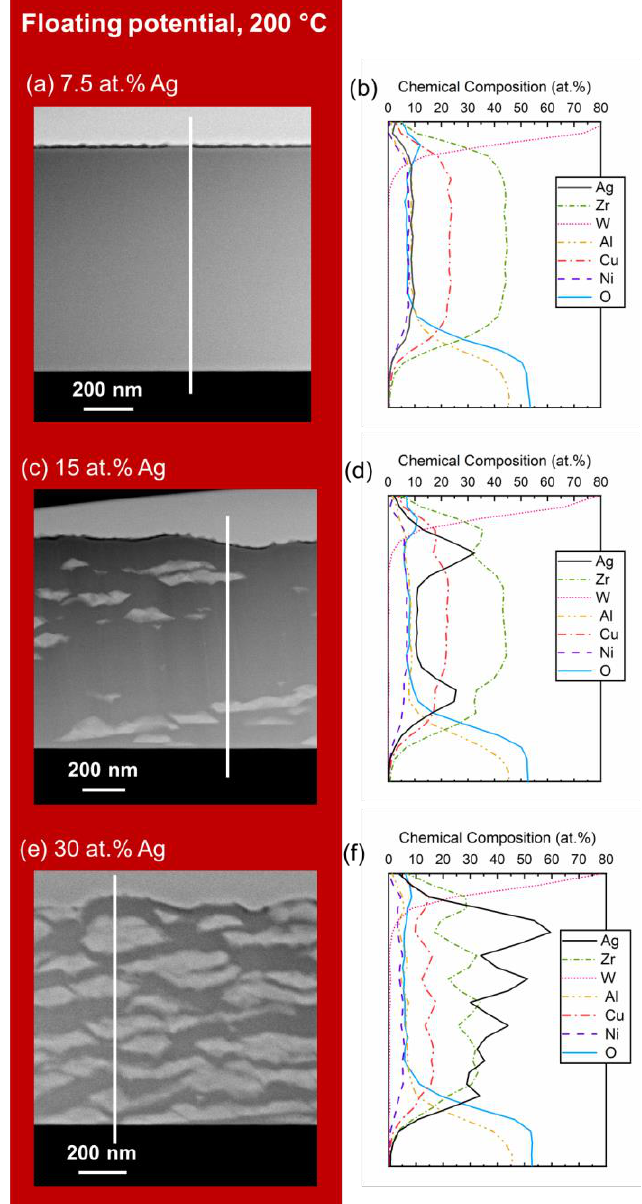
Figure 5. STEM cross-sectional HAADF images and corresponding EDX line scans of the films deposited at 200 °C, under floating potential, containing ( a , b ) 7.5, ( c , d ) 15, and ( e , f ) 30 at.% Ag.